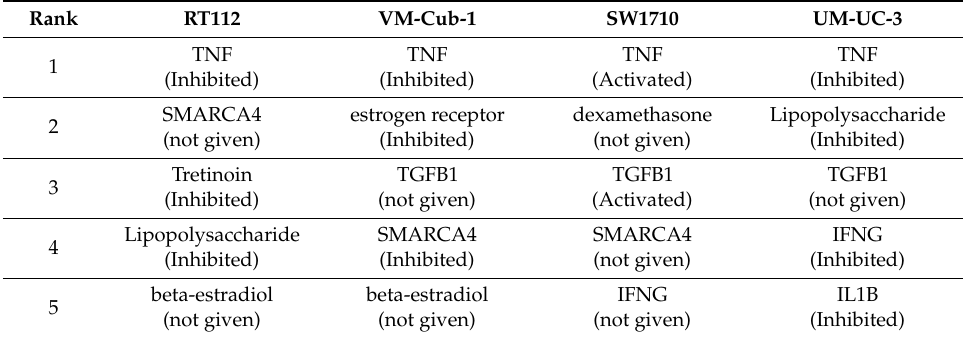
Table 3. Top upstream regulators (and their predicted activation) in HDAC5 versus vector-only transduced UC cell